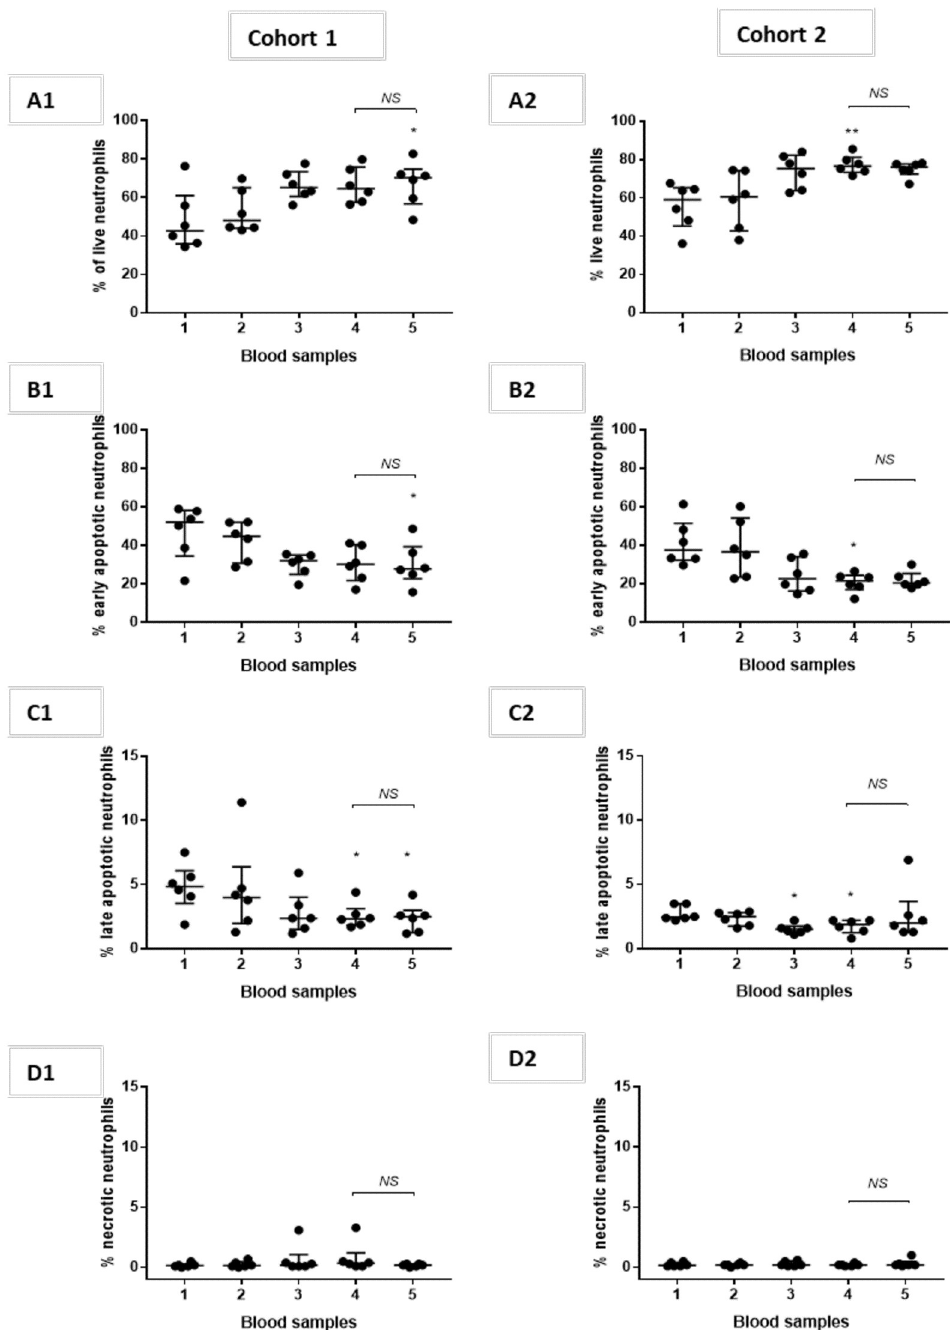
Fig 3. Neutrophil apoptosis. Data are presented as scatter plots with median (middle bar) and interquartile range (whiskers). Left-sided graphs represent cohort 1 (n = 6) and right-sided graphs cohort 2 (n = 6). [A1] and [A2] percentage of live neutrophils, [B1] and [B2] percentage of early apoptotic neutrophils, [C1] and [C2] percentage of late apoptotic neutrophils and [D1] and [D2] percentage of necrotic neutrophils. The Friedman test with Dunn’s post-hoc multiple comparisons was used to compare values between sample 1 and samples 2–5. Wilcoxon’s matched pairs signed rank test compared samples 4 and 5. Abbreviations NS: non-significant.